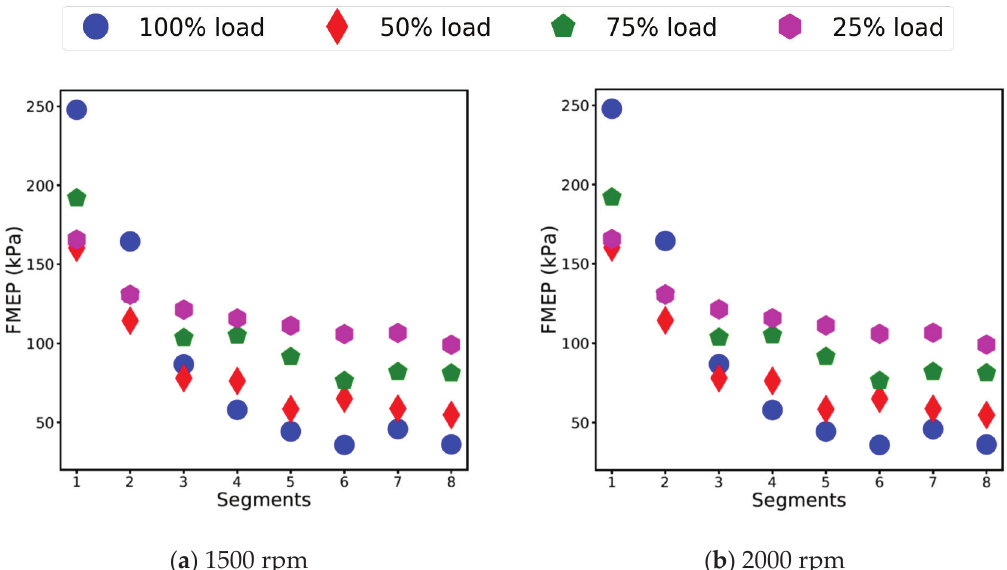
Figure 7. Brake mean effective pressure (BMEP) at each load in each segment at ( a ) 1500 and ( b ) 2000 rpm. The blue circle represents 100% load, the red diamond 50% load, the green pentagon 75% load and the pink hexagon 25% load.